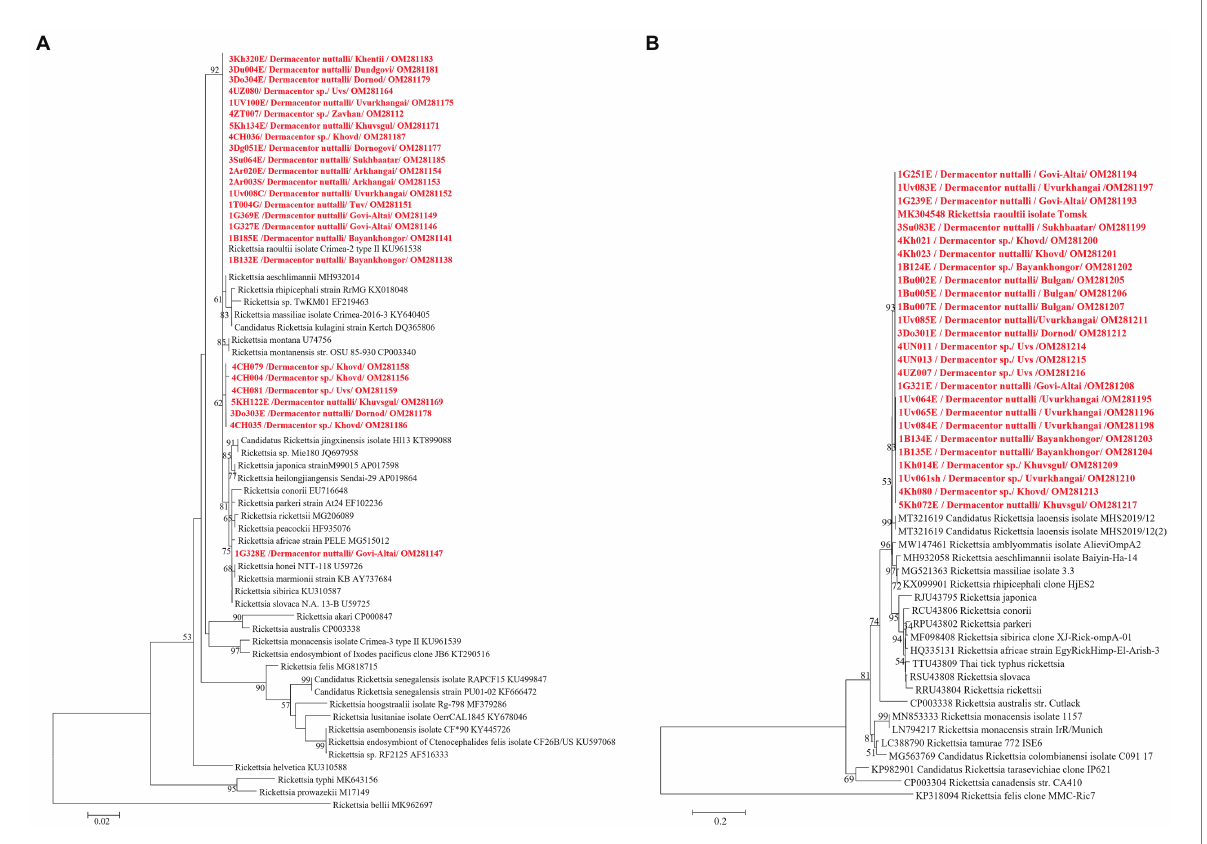
FIGURE 3 Maximum likelihood (ML) tree was constructed from glt A gene (A) and omp A gene (B) of Rickettsia spp. using T92 + G model with 1,000 bootstrap replicates (> 50% are shown on each node). Sequences of tick samples in this study are shown in red letters.